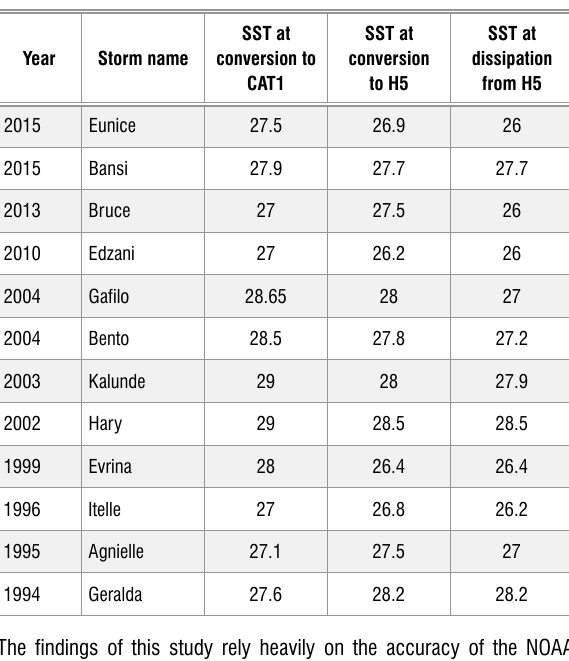
Sea surface temperature (SST, °C) conditions for the South Indian Ocean CAT5 tropical